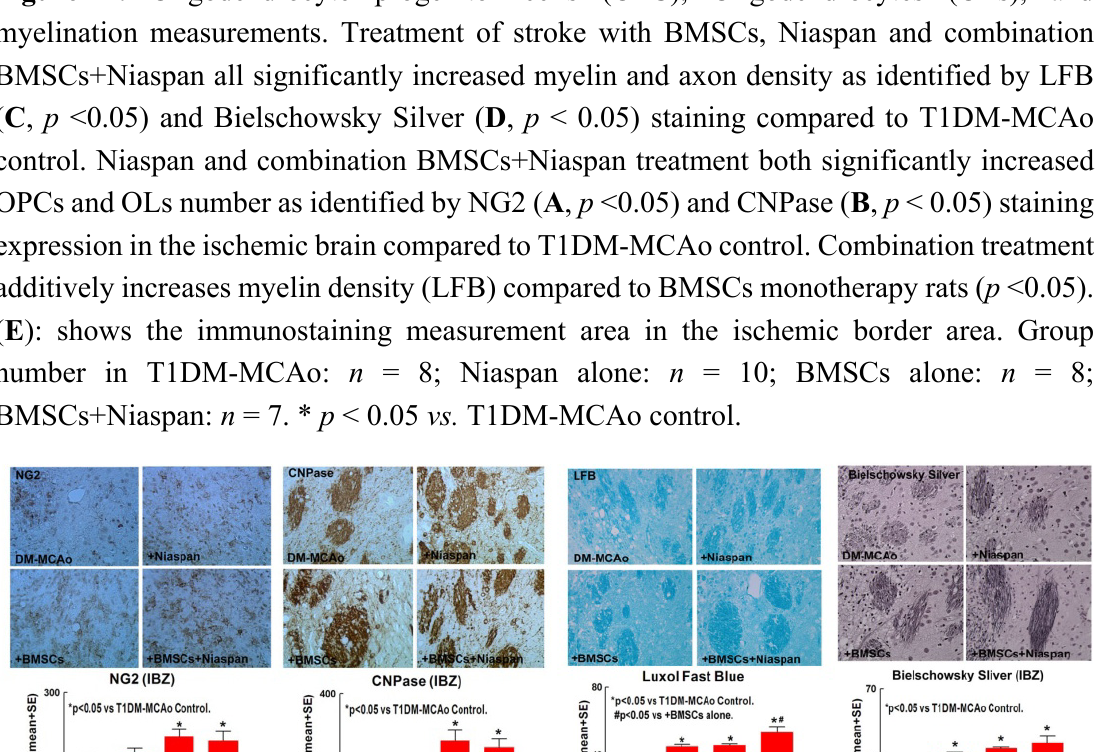
Figure 1. Oligodendrocyte progenitor cells (OPC), Oligodendrocytes (OLs),